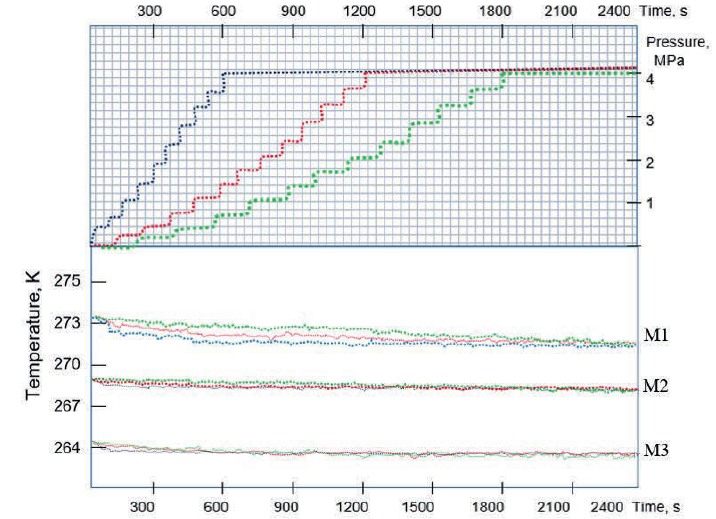
Fig. 5. Thermograms of hydrate formation at the final